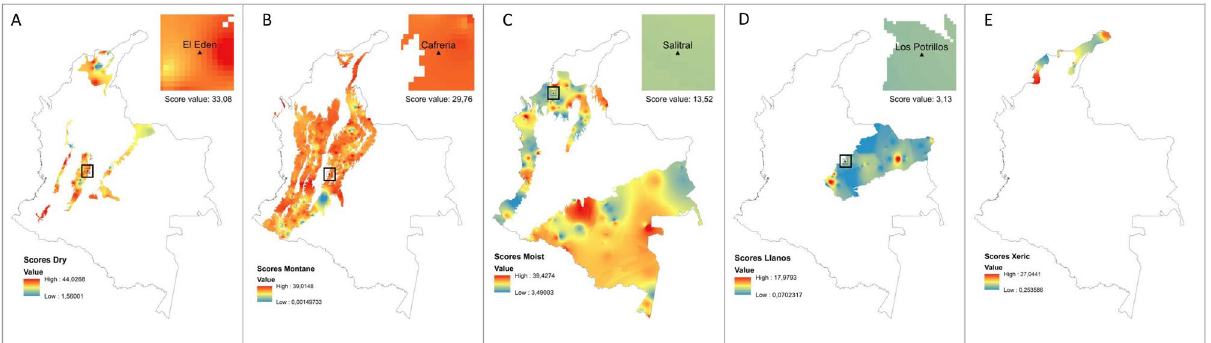
Figure 3. Predicted risk of sand fly presence based on the sum of score values by mammal genus, using the inverse distance weighted (IDW) method in ArcGis 10.7.1. (https:// deskt op. arcgis. com/ en/ arcmap/) Copyright 1995–2018 Esri. All rights reserved. Published in the United States of